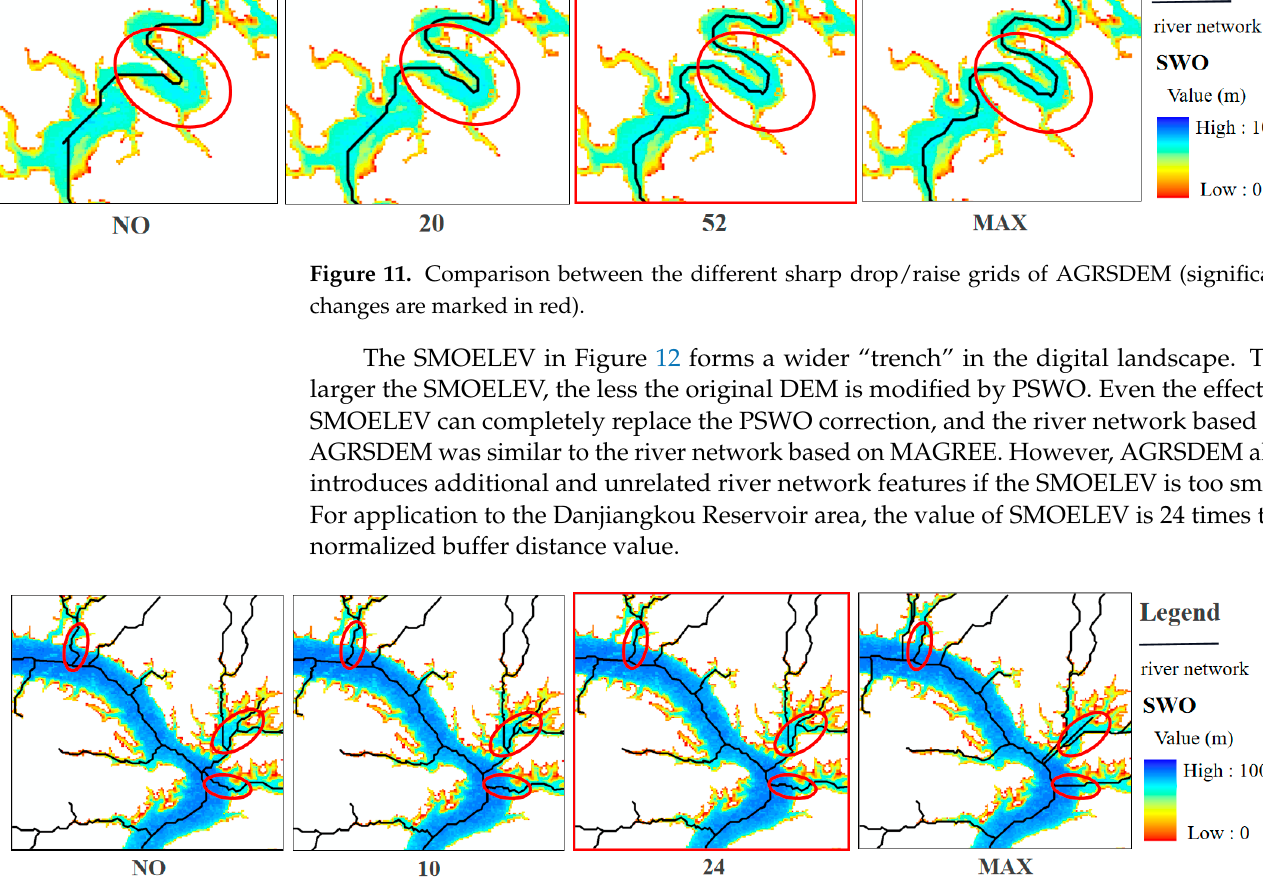
Figure 12. The comparison between the different smooth modified elevation grids of AGRSDEM (significant changes are marked in red).